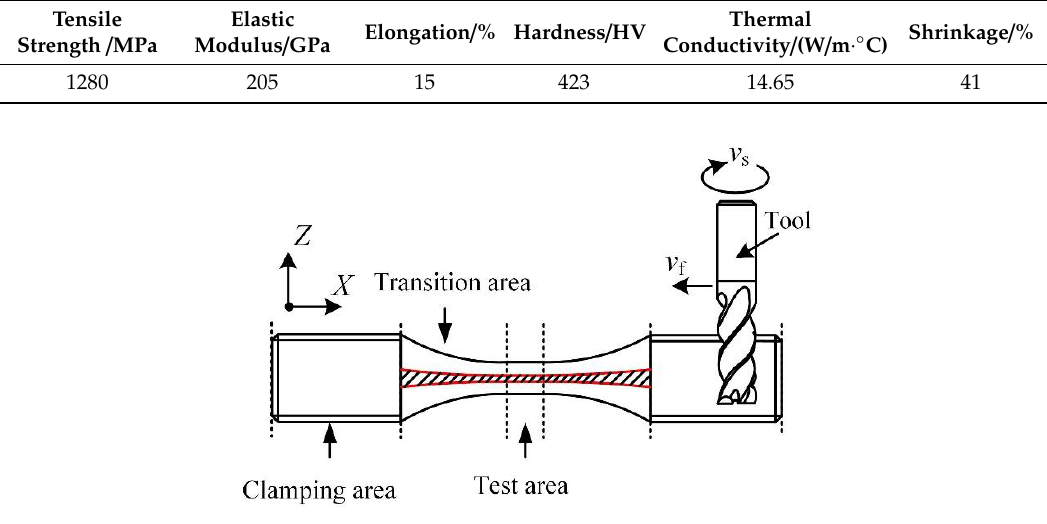
Table 2. The mechanical properties of the GH4169 superalloy.